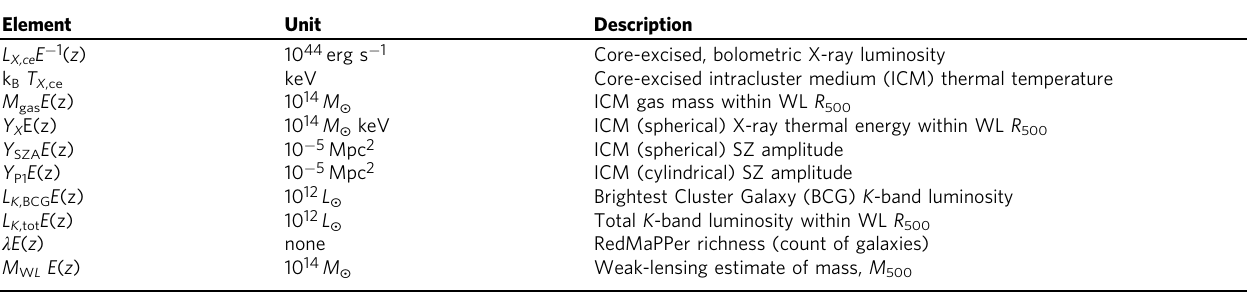
Table 1 Non-selection elements of the property vector of the LoCuSS cluster sample Element